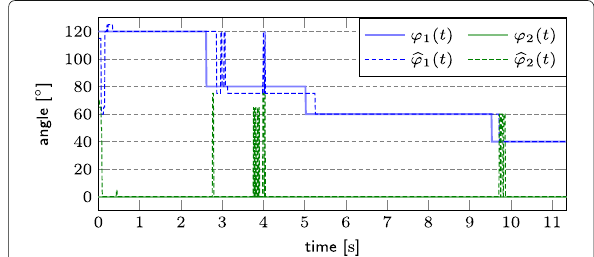
Fig. 10 Ground truth (solid lines) and estimated (dashed) azimuth angles of arrival for the considered audio example. Major errors occur especially after DOA changes and during speech